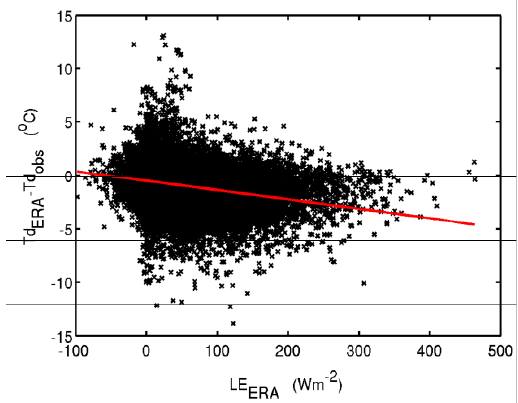
Figure 6. Difference between the ERA-Interim and observed dew point temperature as a function of the latent heat flux, derived from ERA-Interim air pressure, air temperature, humidity, SST, and wind speed by applying the GEOMAR bulk flux scheme. The red line gives the result of a linear regression.